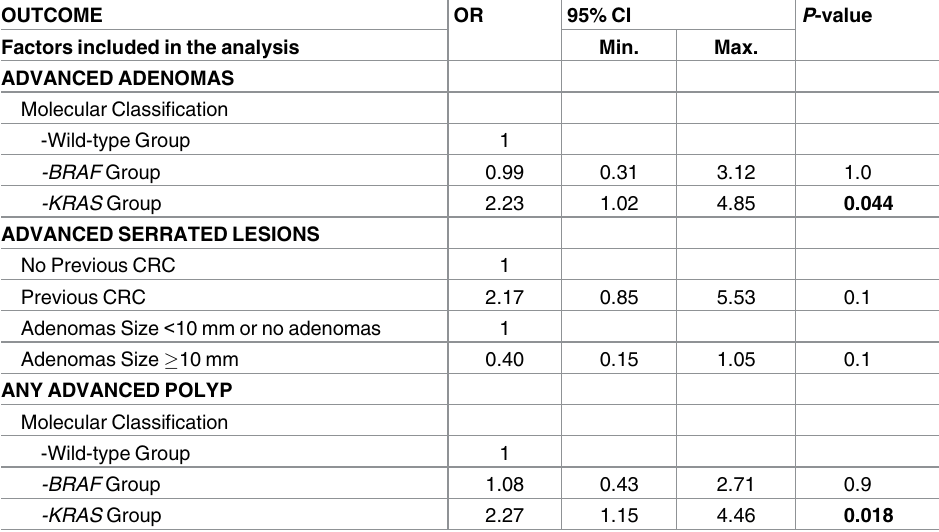
Abbreviations: CI: confidence interval; CRC: Colorectal cancer; OR: odds